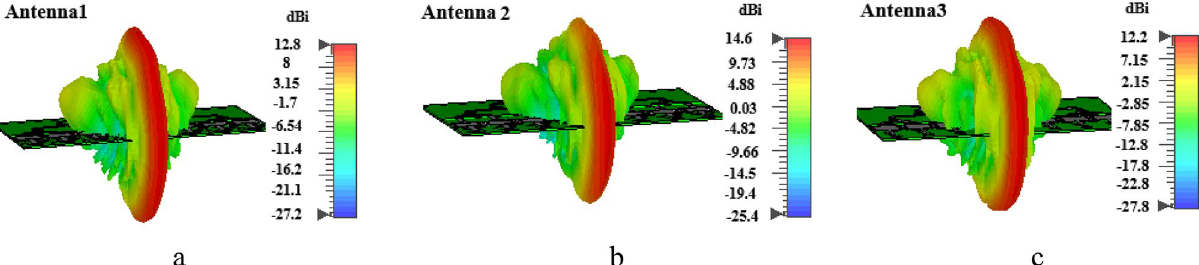
Figure 6. The 3D radiation pattern and calculated gain value of: ( a ) antenna1, ( b ) antenna2 and ( c ) antenna3.